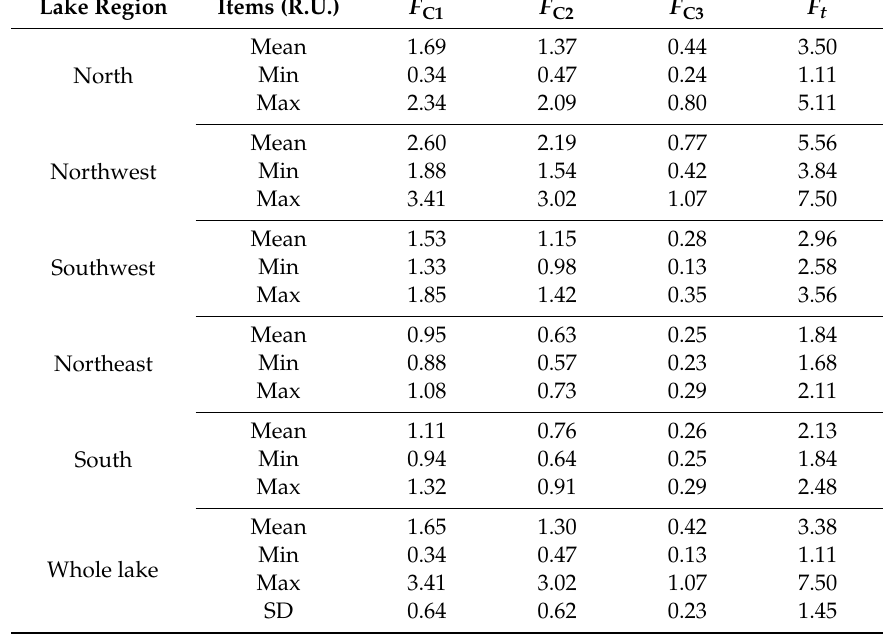
Table 2. Fluorescence intensities of components C1 ( F C1 ), C2 ( F C2 ), C3 ( F C3 ), and the total fluorescence intensity ( F t ) of fluorescent DOM (FDOM) in the overlying water of Taihu Lake. Lake Region Items